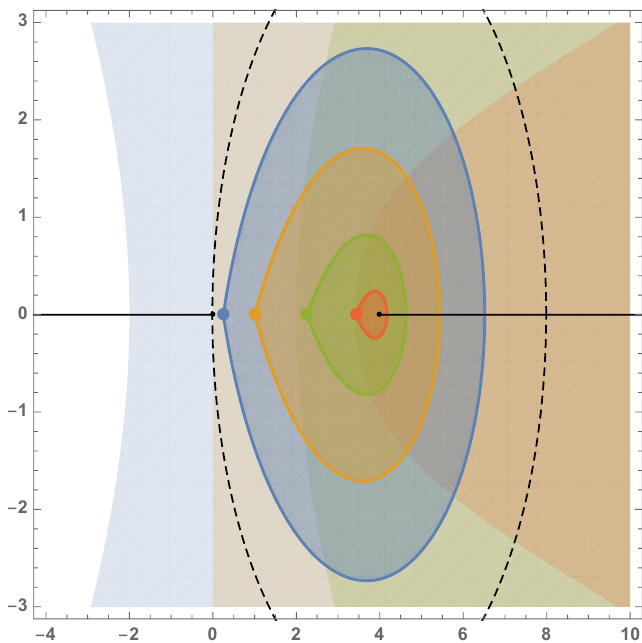
Figure 17. Light shading: regions in the complex s plane where we pick up poles in the Mellin amplitude. Dark shading: regions where these poles dominate and our flat-space limit diverges. We have set m = 1 and the blue, orange, green and red domains respectively correspond to m b = 0 . 5 , 1 , 1 . 5 , 1 . 85 . We have also highlighted the pole at s = m 2 for each color as well as the cut at b s = 4 . Although this is not entirely obvious from the plot, the blue region extends rightward to include the orange, green and red regions and similarly for the other